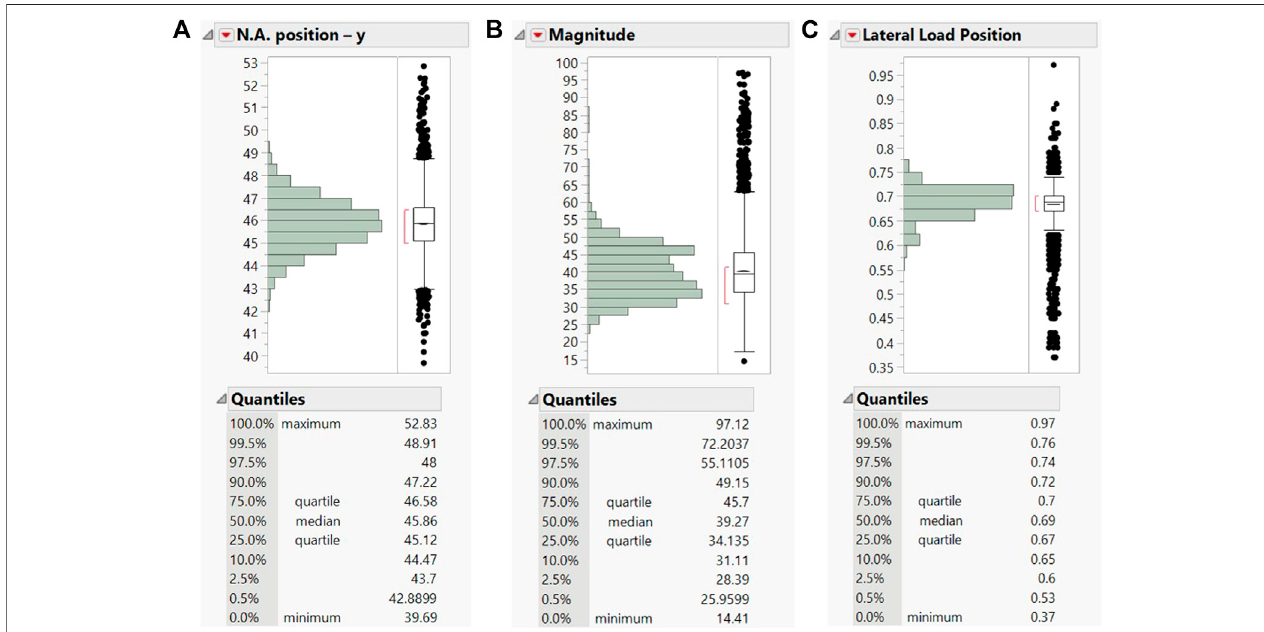
FIGURE6 | For the controlling location (CL) of west girder the distribution of (A) N.A. position (in), (B) magnitude of thetrucksweight ( με ), and (C) lateral position of the truck traf fi c (unitless).